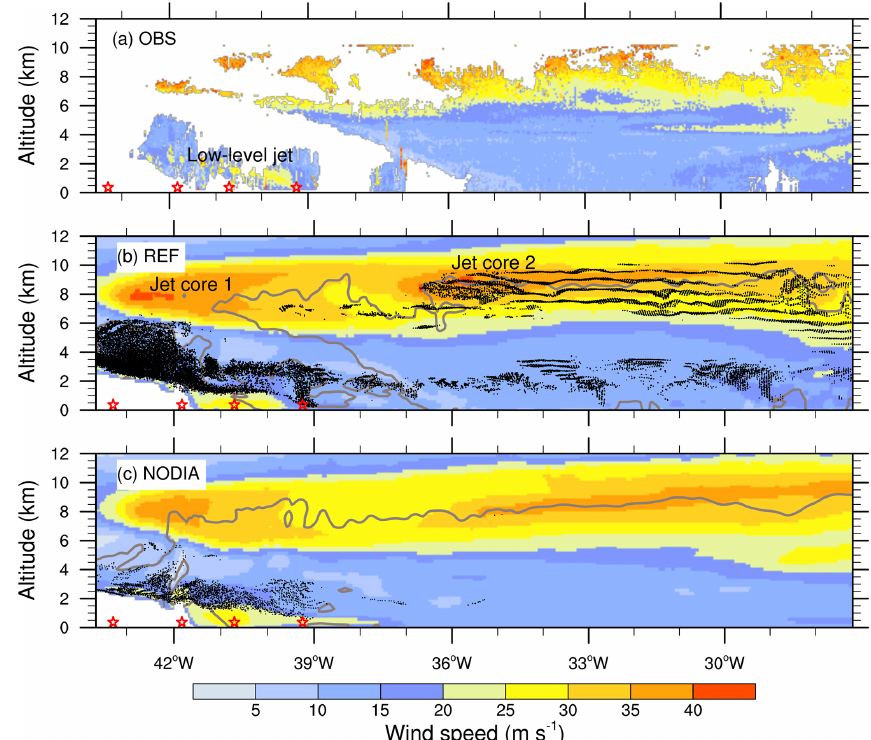
Figure 3. Horizontal wind speed (in ms − 1 ) (a) measured by RASTA and simulated by (b) REF and (c) NODIA along the 11:00UTC leg (black line in Fig. 1). The red stars indicate the position of the dropsondes shown in Fig. 4. In (b) and (c) , the black dots indicate the position of the selected ascents (see text for details), and the gray lines show the condensed water content equal to 0.02gkg − 1